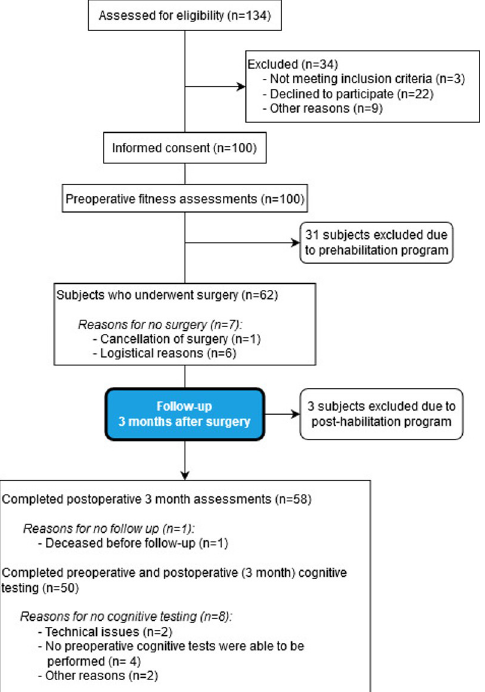
Fig 2. CONSORT flow diagram. A consort flow diagram of all the patients included into the